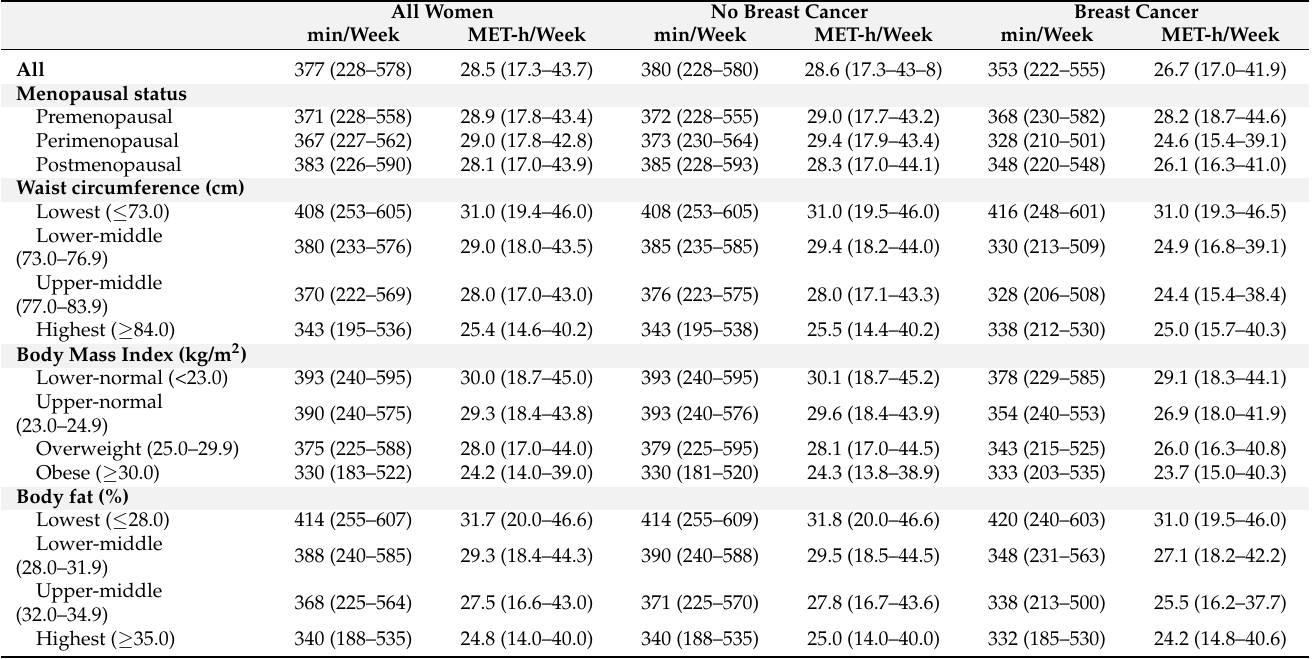
Table 2. Physical activity levels according to menopausal status or body composition, among all women and by breast cancer status.